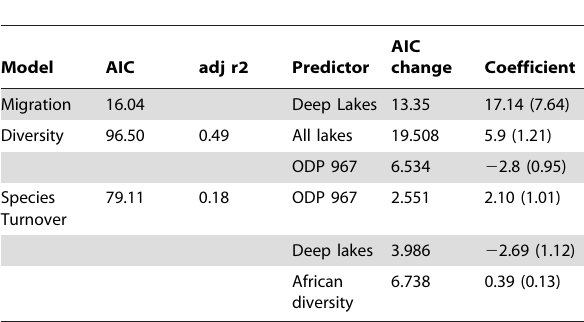
Table 2. Lake presence and Mediterranean dust records predict hominin dispersal and diversity patterns (0–3